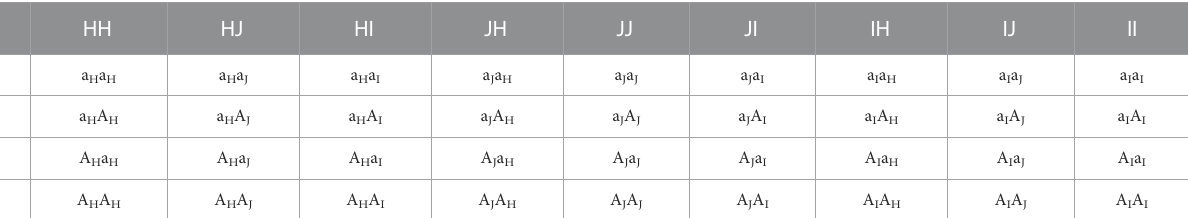
TABLE 2 Ancestry genotype combinations for three-way